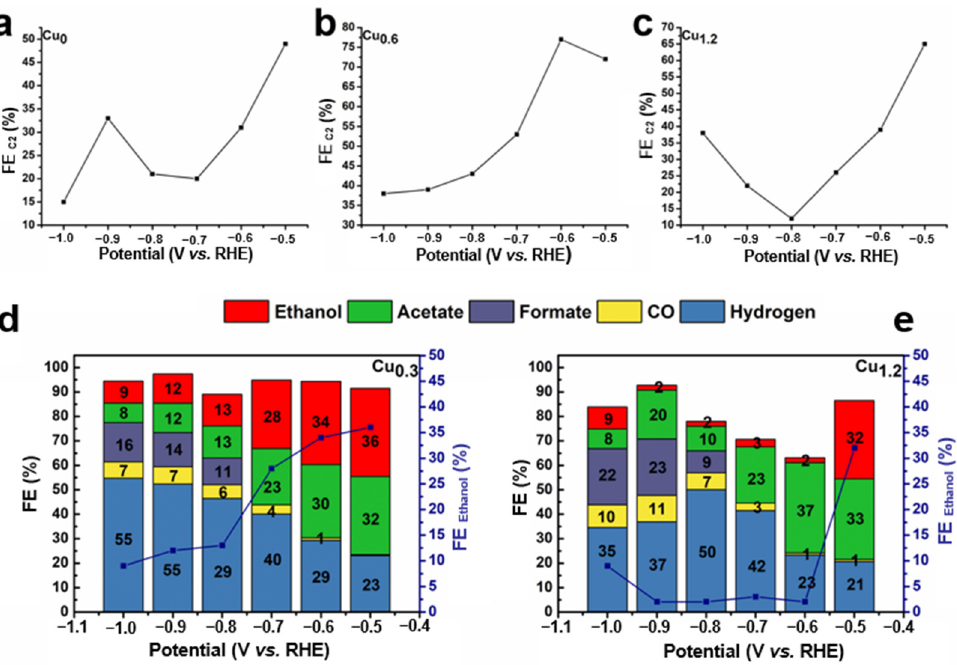
Figure 9. FE of C 2 for ( a ) Cu 0 , ( b ) Cu 0.6 , and ( c ) Cu 1.2 under different potentials. FE of each CO 2 reduction products for ( d ) Cu 0.3 , ( e ) Cu 0.9 under different potentials.